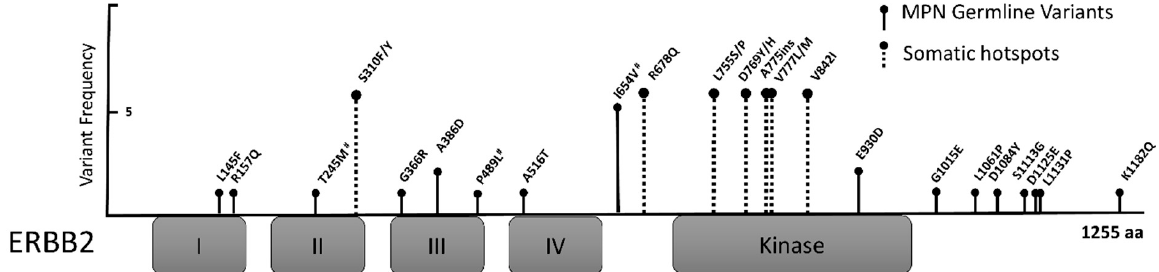
Figure 2. Germline ERBB2 variants identified via target sequencing. Location of germline variants in the ERBB2 protein identified in cases with a myeloproliferative neoplasm. The amplitude of the “stem” for each germline variant corresponds to its frequency in the cohort. Variants are found throughout the protein, but they spare somatic hotspot regions (dashed lines) including p.S310 and the kinase domain. Extracellular domains are labelled I–IV, and the kinase domain is indicated. # denotes germline variants that have been previously reported in cancer predisposition. aa, amino acids.